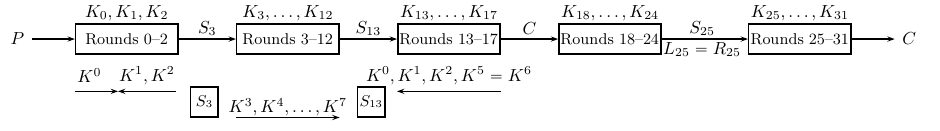
Figure 2: A schematic description of the reflection